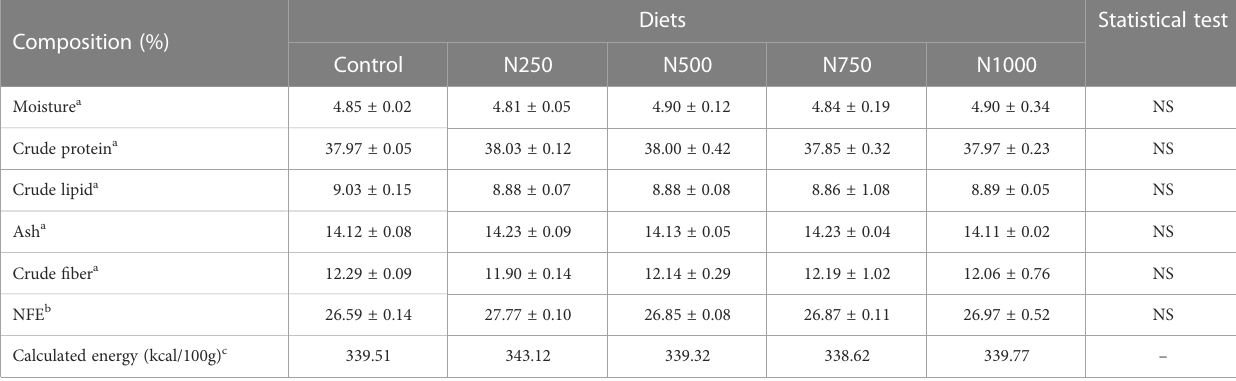
TABLE 2 Proximate composition of diets for white shrimp. Composition (%)